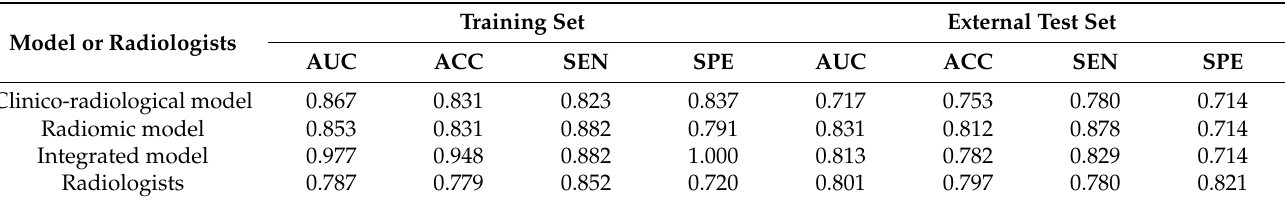
Table 2. Diagnostic performance of models and radiologists.